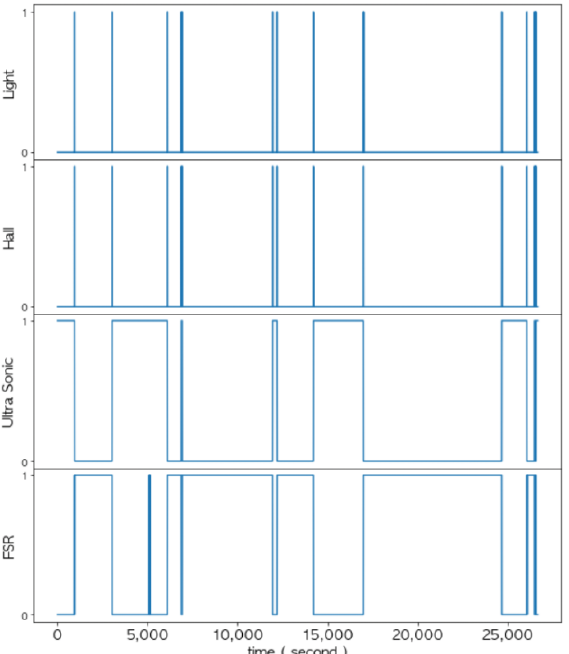
Figure 19. A set of graphs that refine the measurement values of each sensor into logical values.